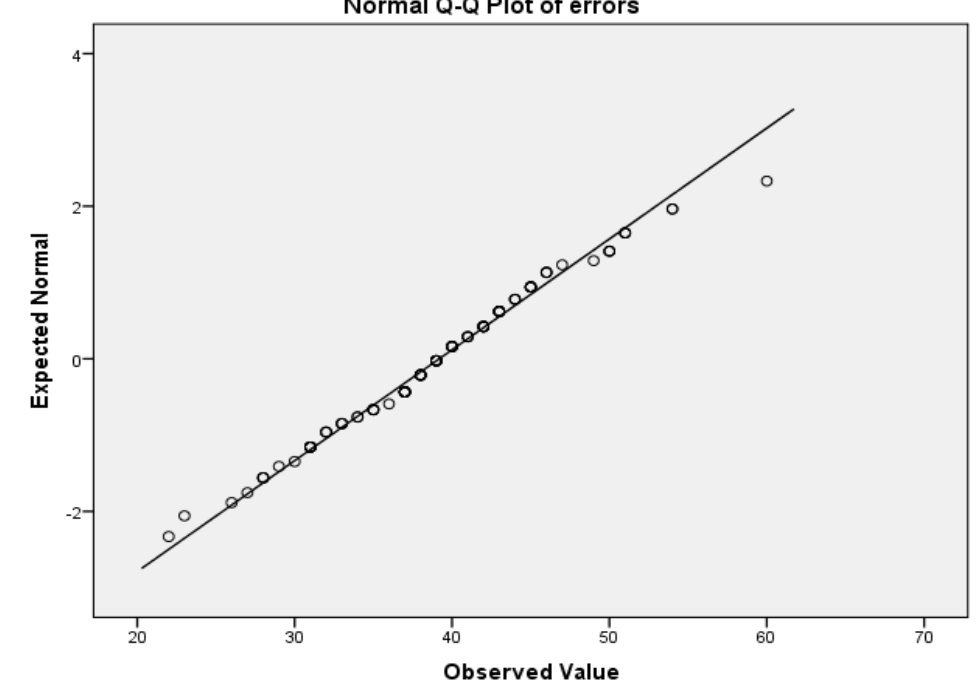
Figure 4. Q - Q plot for the number of errors.